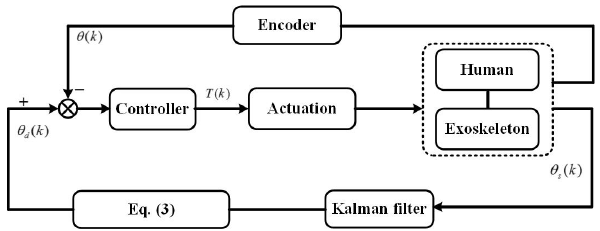
Figure 12. The control diagram for the lower extremity exoskele- ton.